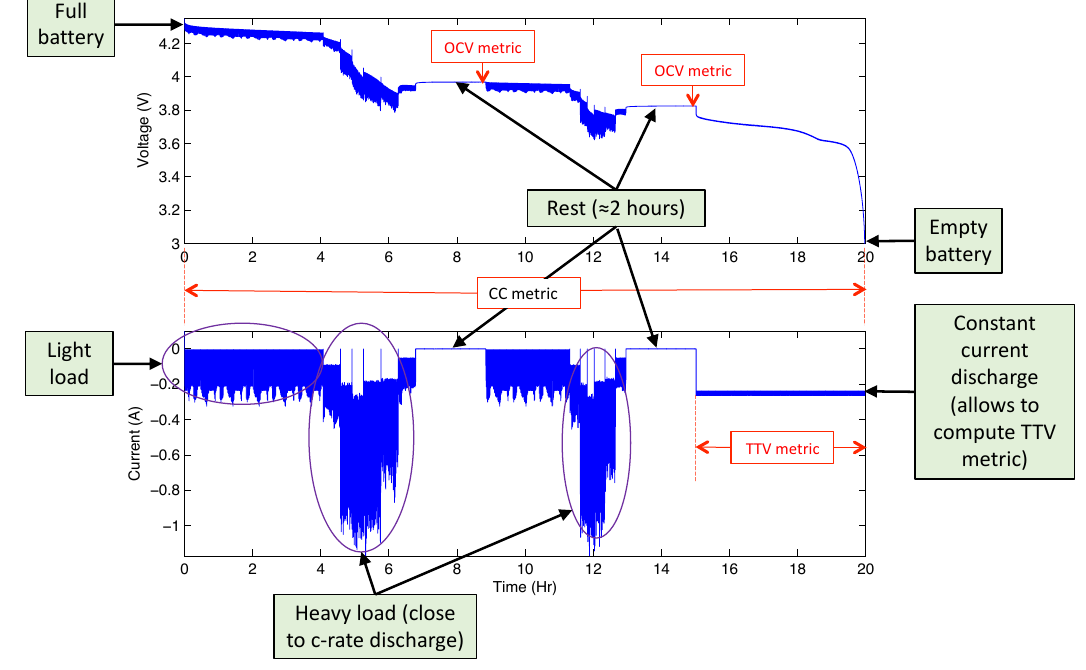
Figure 11. BFG evaluation profile. The battery fuel gauge evaluation profile is a specially designed load current profile that allows to implement all three BFG evaluation metrics: CC-metric , OCV-metric and the TTV-metric . The profile starts with a full battery and ends when the battery becomes empty; this allows to compute the battery capacity accurately. Intermittent rest periods within the profile allows to compute the OCV metric and the constant current load profile allows to compute the TTV